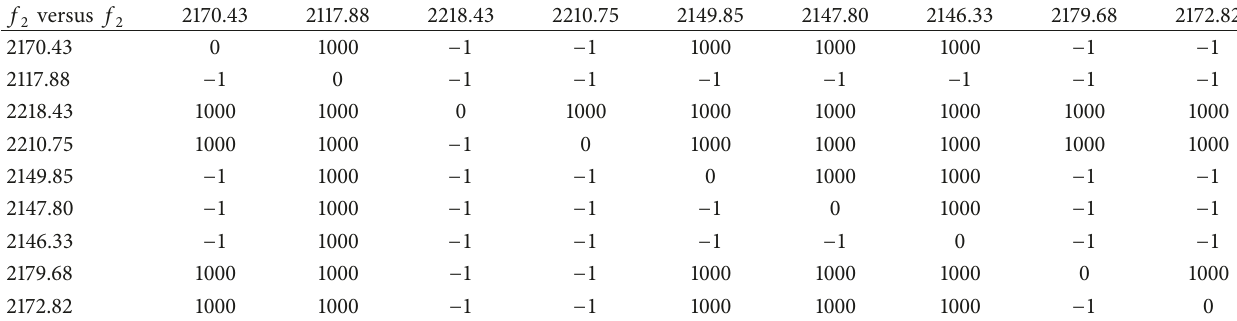
compares all the solutions k from objective f 2